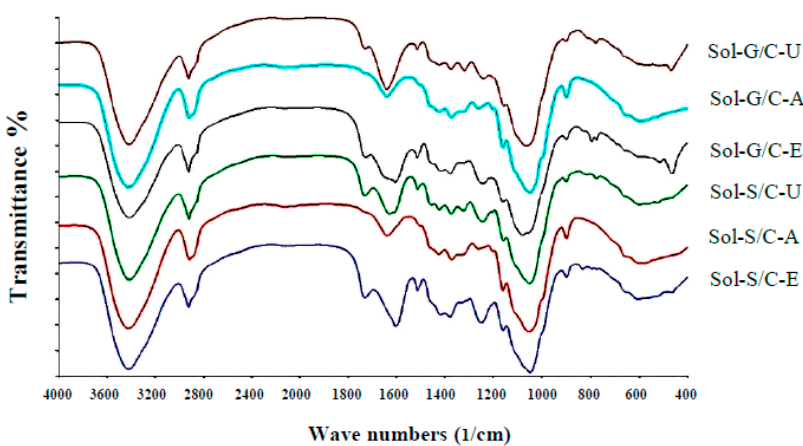
Figure 5. FTIR of spectra of solid residues from a co-digestion of grass with cow dung (Sol-G/C) and silage with cow dung (Sol-S/C) subjected to different pretreatment methods. (Untreated solid residues of grass with cow dung (Sol-G/C-U); solid residues of grass with cow dung pretreated by alkaline pretreatment (Sol-G/C-A); enzyme pretreatment (Sol-G/C-E); Untreated solid residues of silage with cow dung (Sol-S/C-U); solid residues of silage with cow dung pretreated by an alkaline pretreatment (Sol-S/C-A); enzyme pretreatment (Sol-S/C-E)).